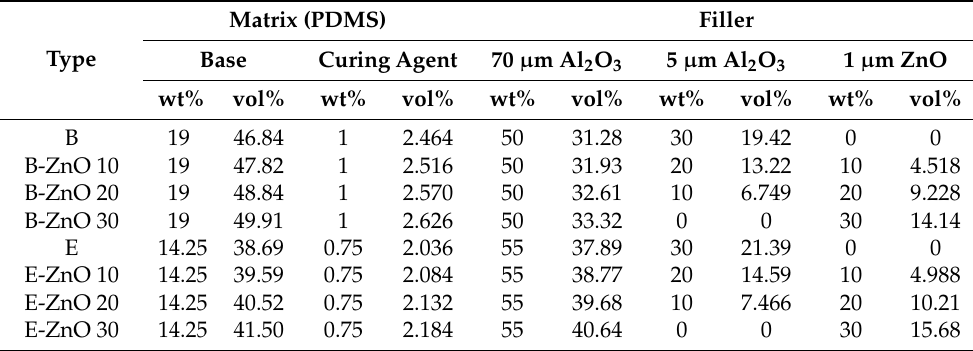
Table 3. Mixing ratio using aluminum oxide and zinc oxide powder.